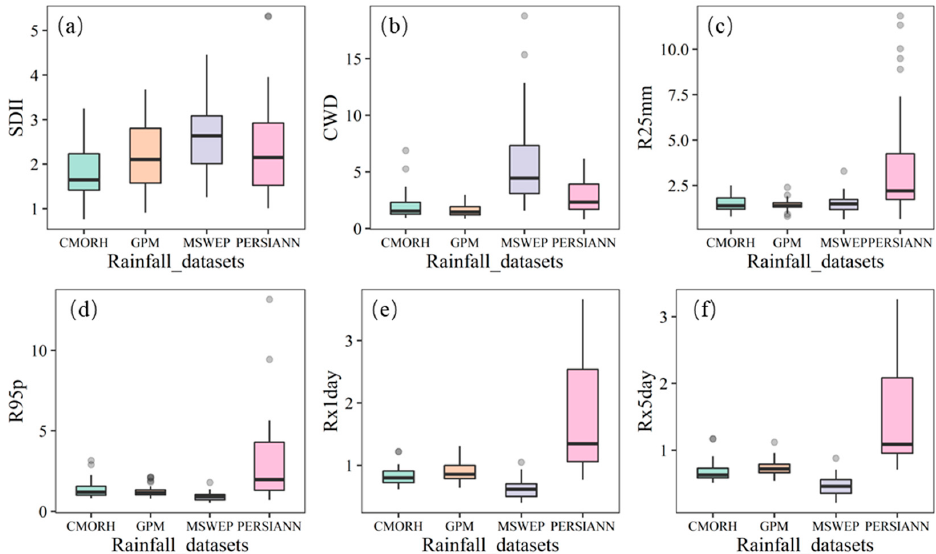
Figure 5. Boxplots showing the RSR values of the four satellite rainfall products at ( a ) SDII, ( b ) CWD, ( c ) R25mm, ( d ) R95p, ( e ) Rx1day, and ( f ) Rx5day. ( c ) R25mm, ( d ) R95p, ( e ) Rx1day, and ( f )